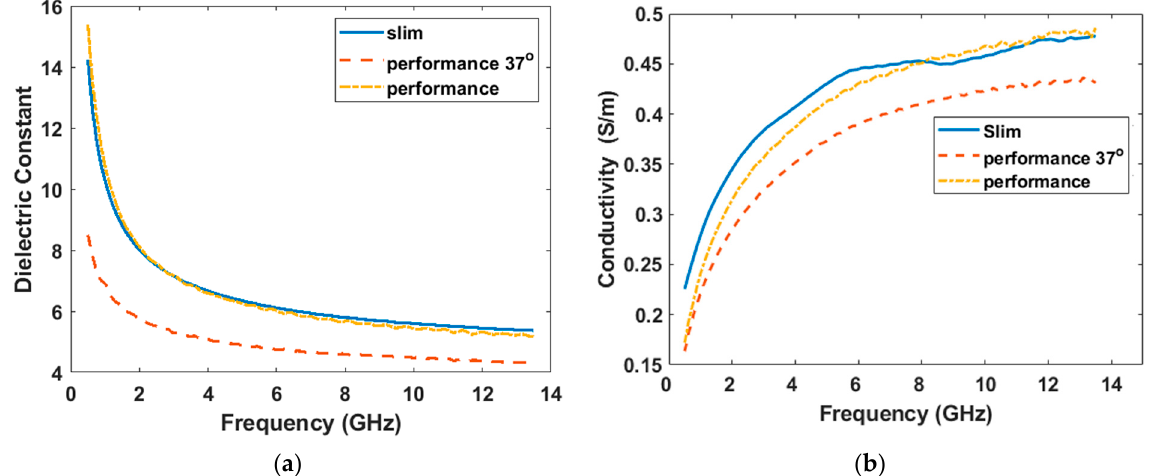
Figure 3. Glycerin measured by a slim-form probe and a performance probe at room temperature, and by a performance probe at 37 °C. ( a ) shows the dielectric constant. ( b ) shows the conductivity. Table 1. Comparison between 99% Isopropyl and Glycerin at room temperature by a slim probe.